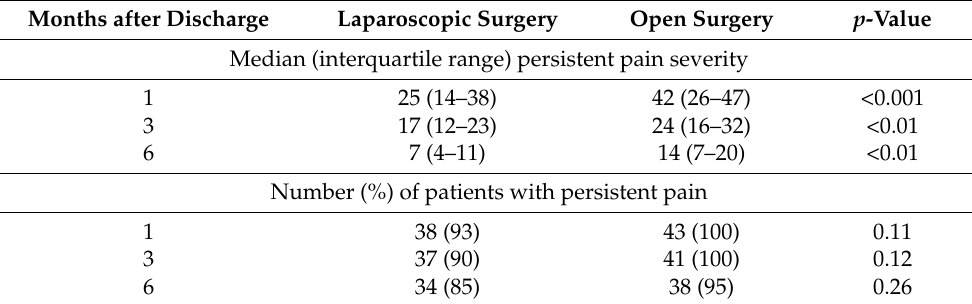
Table 5. Patients with chronic postoperative pain and pain severity measured with the NPSI by surgery